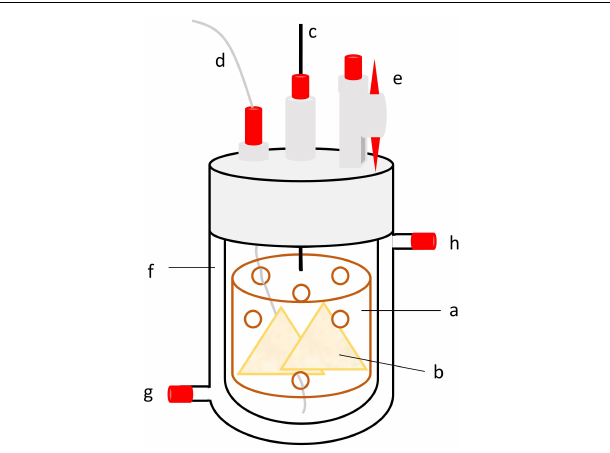
FIGURE 2 | Schematic diagram of a Rusitec fermenter with a feed container (a) containing feed bags (b). The feed container is connected via a bar (c) to a lift motor. Buffer is consistently infused through a tube (d) connected to the buffer pump. The connection to the effluent (e) is closable to make it possible to remove the fermenter. The heating jacket (f) is connected via an inflow (g) and outflow (h) to a circulation